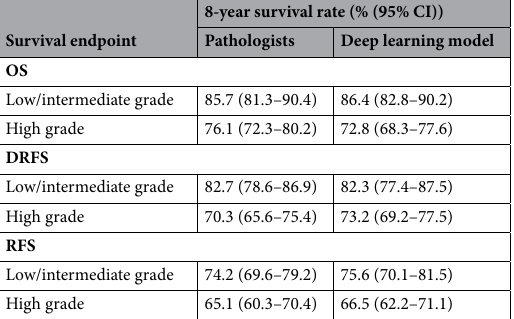
Table 4. Eight-year survival rates of low/intermediate and high grade groups as assigned by pathologists and the deep learning model for overall survival (OS), distant recurrence free survival (DRFS) and recurrence free survival (RFS). Results are shown on the test set ( n = 686).